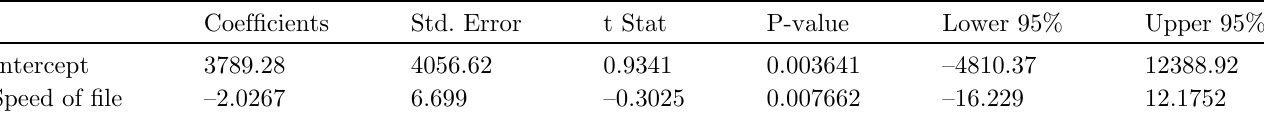
Table 10. Analysis of variance (intercept and variable).